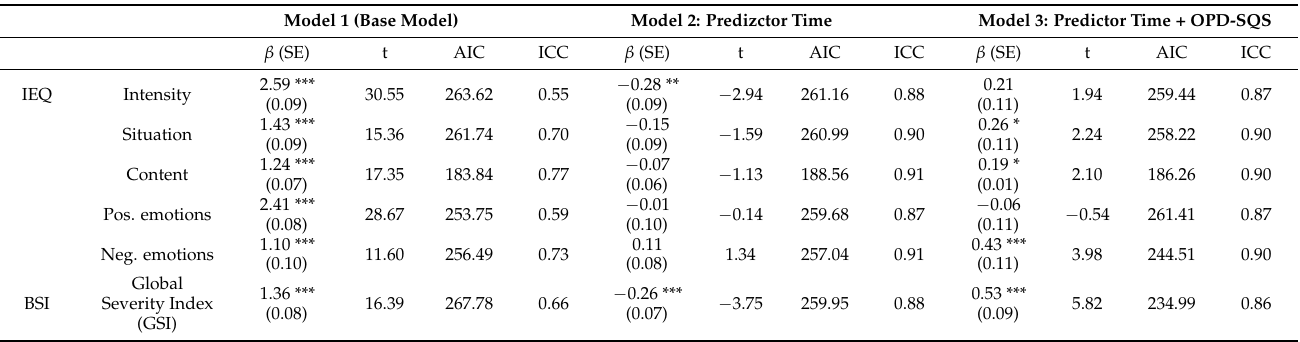
Table 4. Results of the multilevel modeling for the prediction of intersession experiences and symptom distress. Model 1 (Base